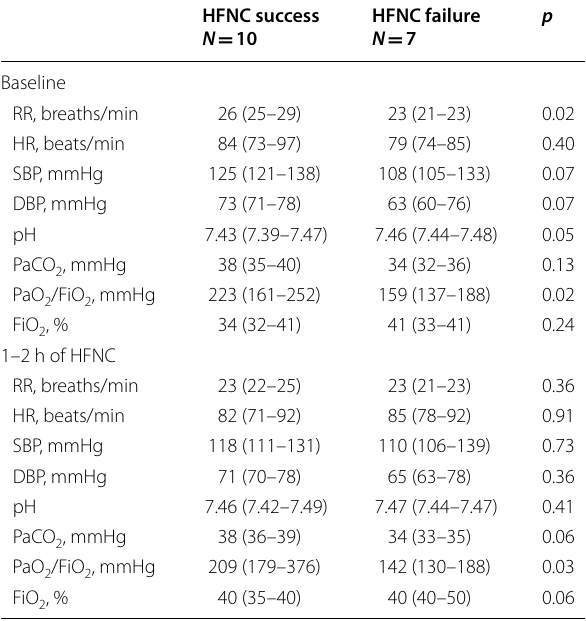
Table 2 Vital signs and arterial blood gas tests at